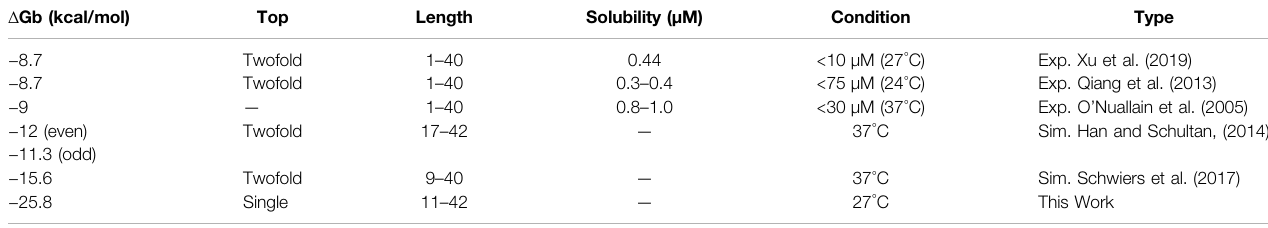
TABLE 1 | Thermodynamic binding af fi nity of Abeta binding to a fi bril. Δ Gb